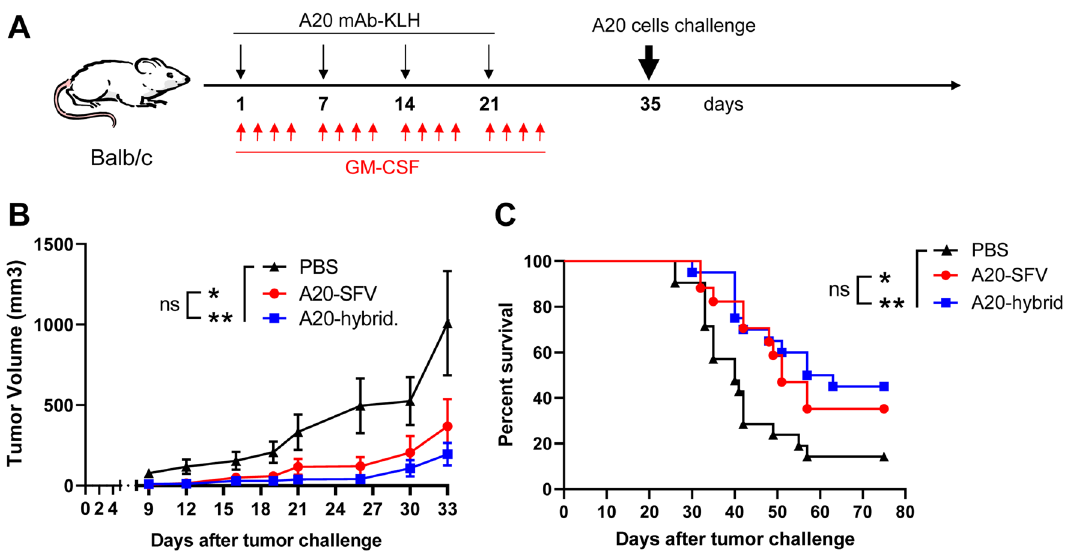
Figure 5. Vaccination of mice with purified A20. ( A ) Balb/c mice were vaccinated with A20 mAb purified from the supernatant of the ncSFV-A20-sgPr cell line (A20-SFV, n = 17) or from A20 hybridoma cells (A20-hybrid., n = 20) conjugated to KLH and in combination with GM-CSF as indicated in the diagram. Control mice received PBS (n = 21). Two weeks after the last immunization, mice were challenged with A20 tumor cells expressing A20 idiotype mAb. ( B ) Tumor growth in each treatment group. Data indicate mean ± SEM. The statistical analysis show comparison of tumor sizes at day 33 ( C ) Survival. Tumor-free mice surviving up to 75 days after tumor challenge were considered long-term survivors. *p < 0.05; **p < 0.01, ns, non significant. In B and C, graphs were generated with Graphpad Prism software (version 9.2.0) and correspond to pooled data of three independent experiments performed with three different batches of A20-SFV idiotype that produced similar results (tumor growth data for each individual experiment are shown in Supplementary Figure